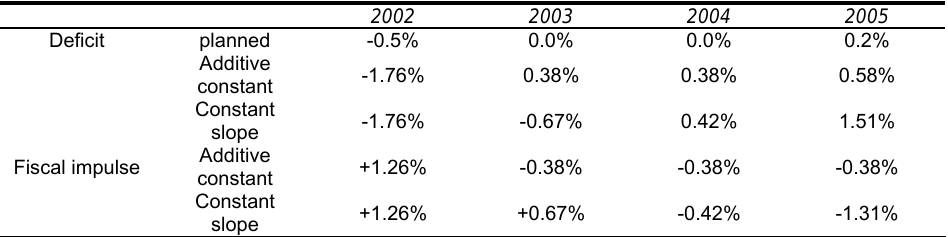
Table 13. Change in the fiscal impulse of the Italian in reaction to a constant slope and constant slope revision of the original SP plan to meet the debt target in